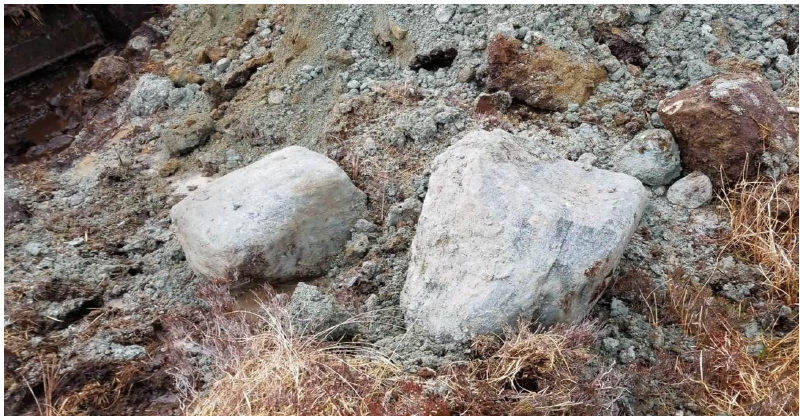
Figure 7. Two of the ten boulders found within the excavated volume are shown. Their diameters are approximately 0.4 m and 0.6 m, and they were distributed throughout the 633 m 3 of the 2019 excavation, but similar boulders were not observed on the surface of the peat bog.